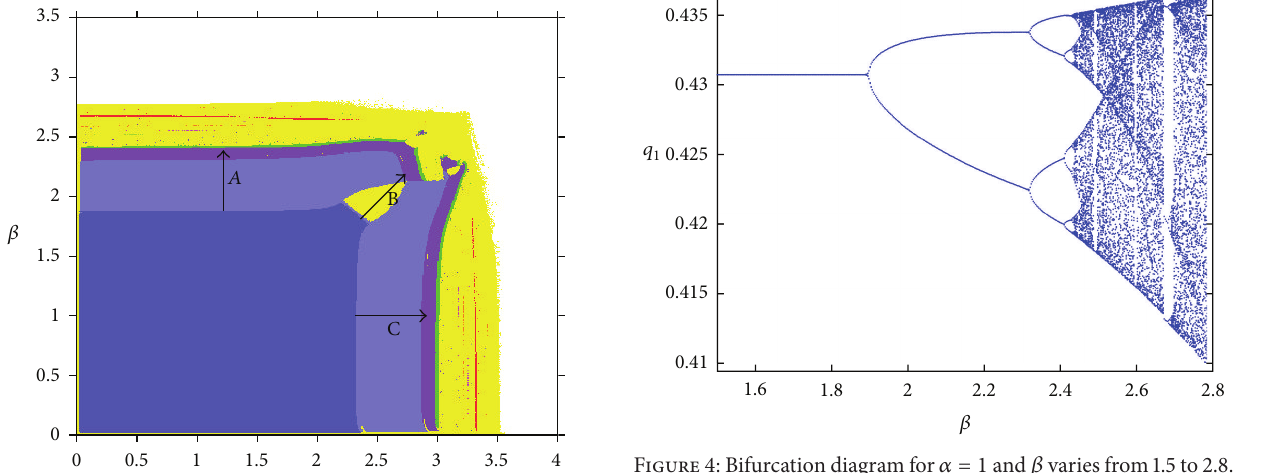
Figure 4: Bifurcation diagram for 𝛼 = 1 and 𝛽 varies from 1.5 to 2.8.